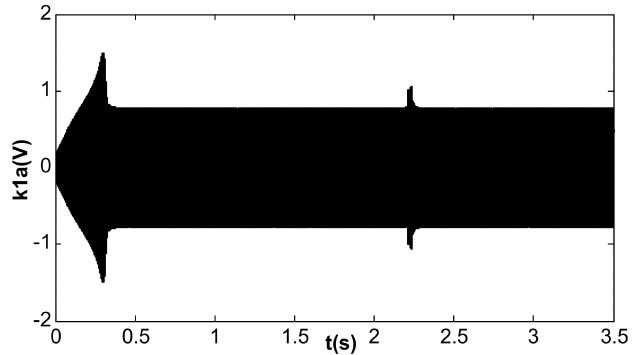
Figure 14. Vibration amplitude under double closed loop ( k I = 100, k II = 2).